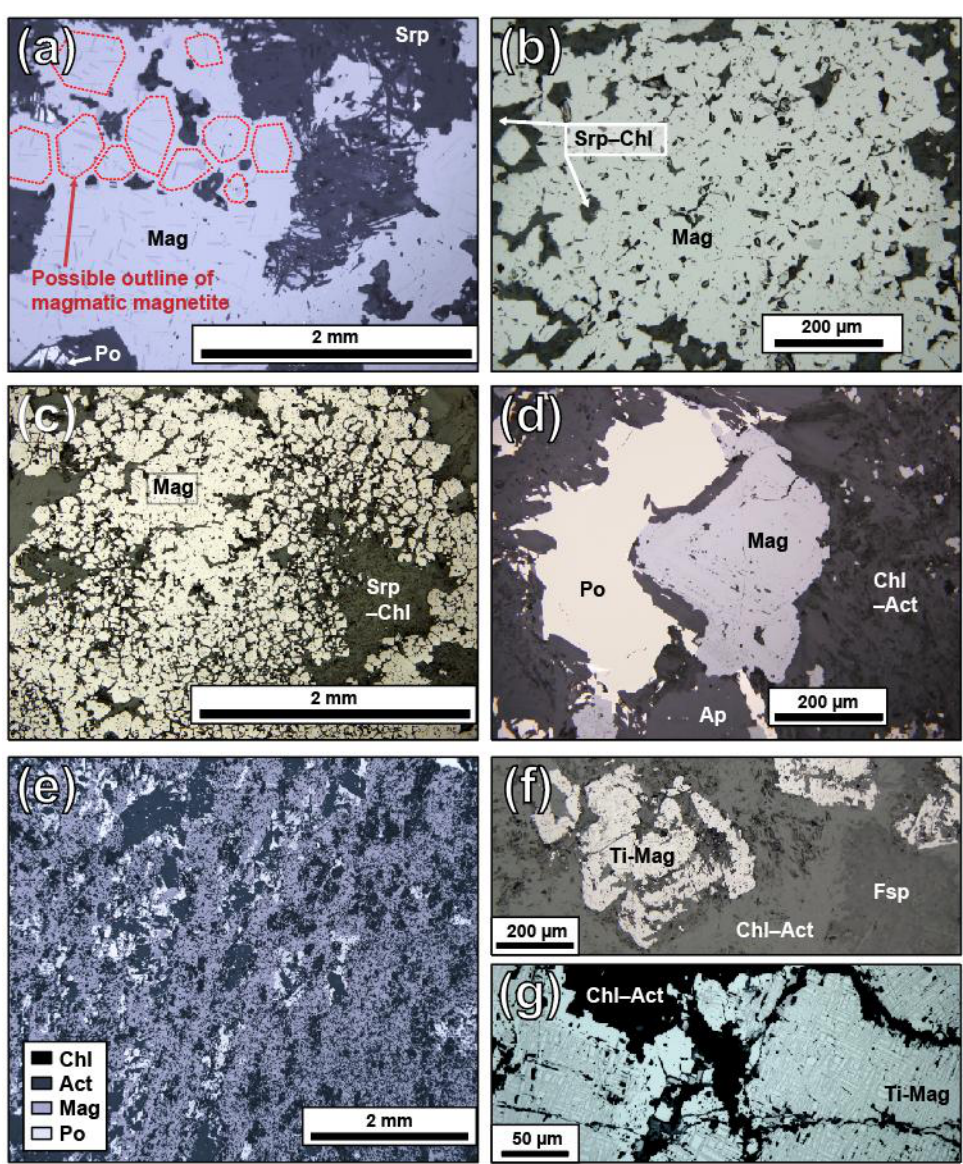
Figure 7. Reflected light images showing magnetite textures in samples: ( a ) MS17-45 (note the ilmenite exsolutions and the chlorite inclusions); ( b ) MS17-36 (granoblastic magnetite with granular chlorite and ilmenite exsolutions); ( c ) MS17-37 (granular magnetite of variable sizes); ( d ) MS17-02 (zoned magnetite); ( e ) MS17-04 (cluster of small magnetites); ( f , g ) MS17-14 (Ti-rich magnetite). The red dashed lines ( a ) outline the possible extent of primary (magmatic) magnetite based on the distribution of the chlorite inclusions and the orientation of the ilmenite exsolutions. Mineral abbreviations are as reported in the literature [34].